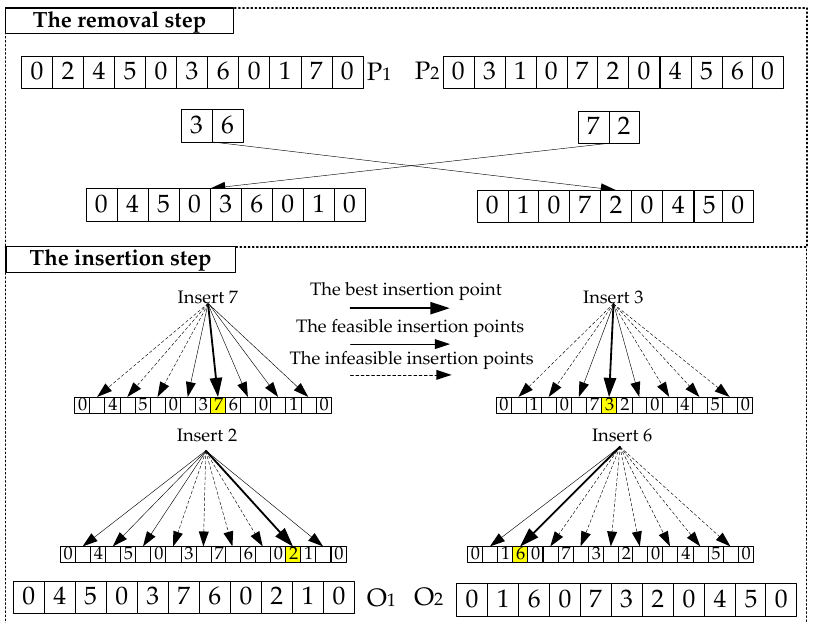
Figure 5. HGA crossover process.